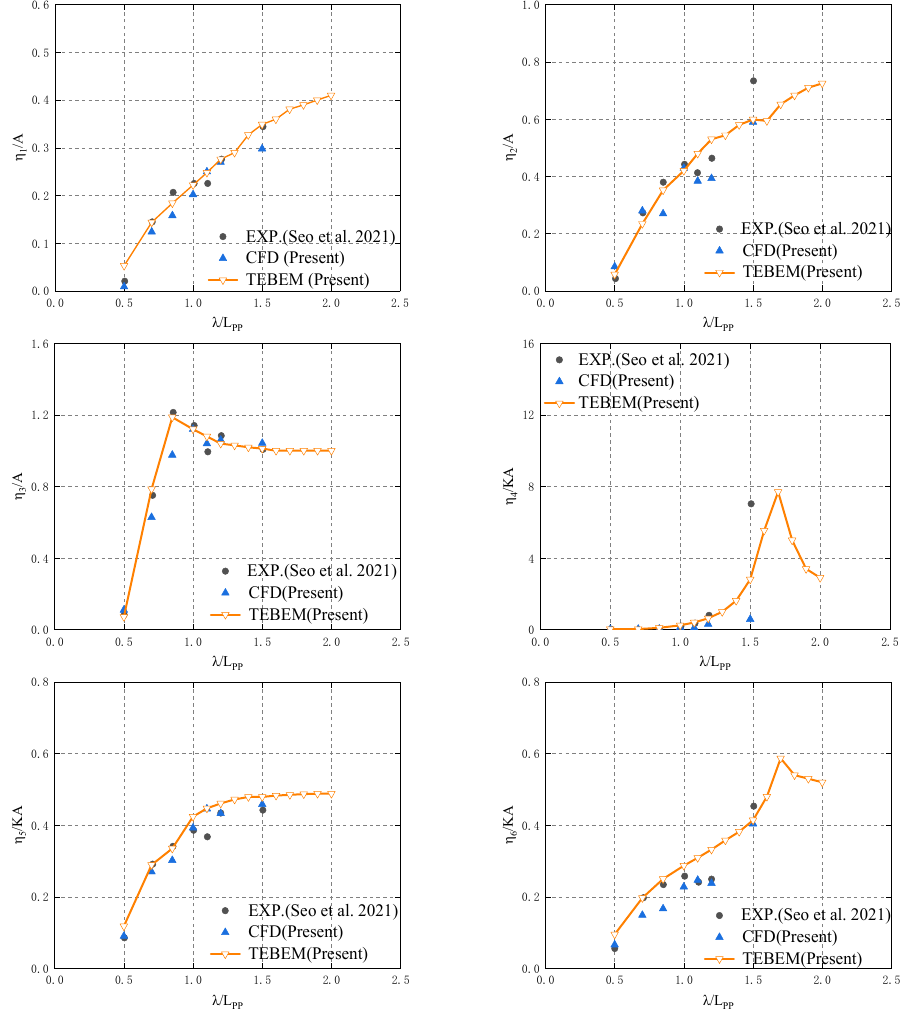
Figure 14. RAO of 6-DOF motion of KVLCC2 under H = 0.02 L PP , χ = 120°, β = 0°, and U = 6.0 kn.